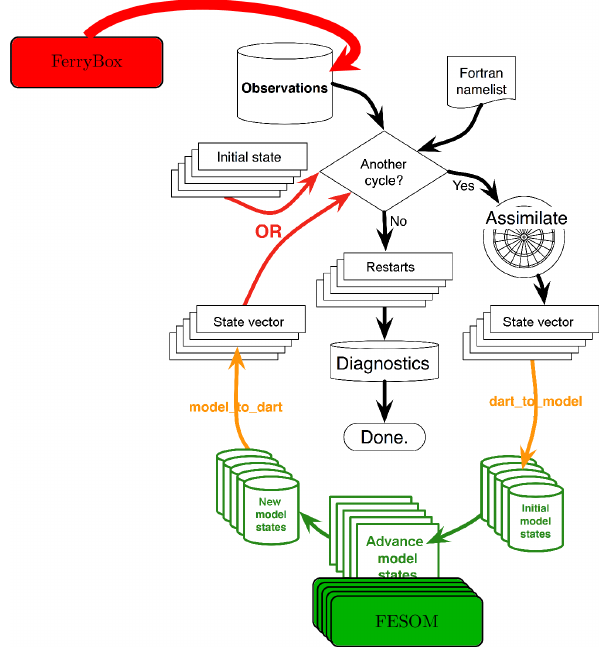
Figure 1. Flow of FESOM–DART system. Reproduced after An- derson et al. (2009) with modifications for the TSS